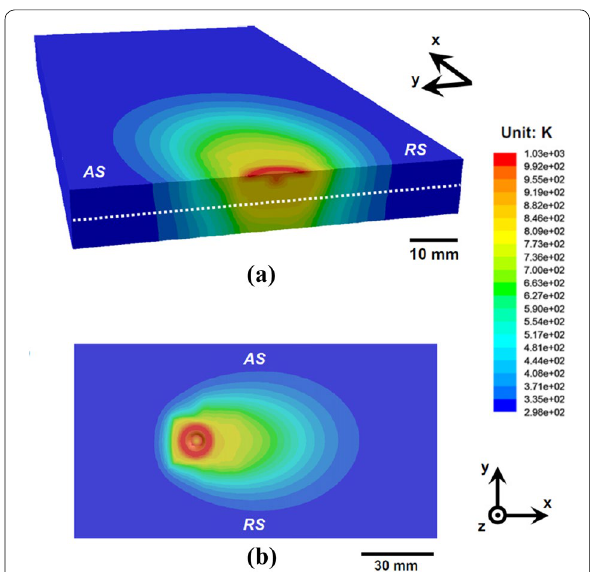
Figure 35 Temperature distribution in the workpiece during the welding: ( a ) the three dimensional view point, ( b ) the top view of the workpiece [83]